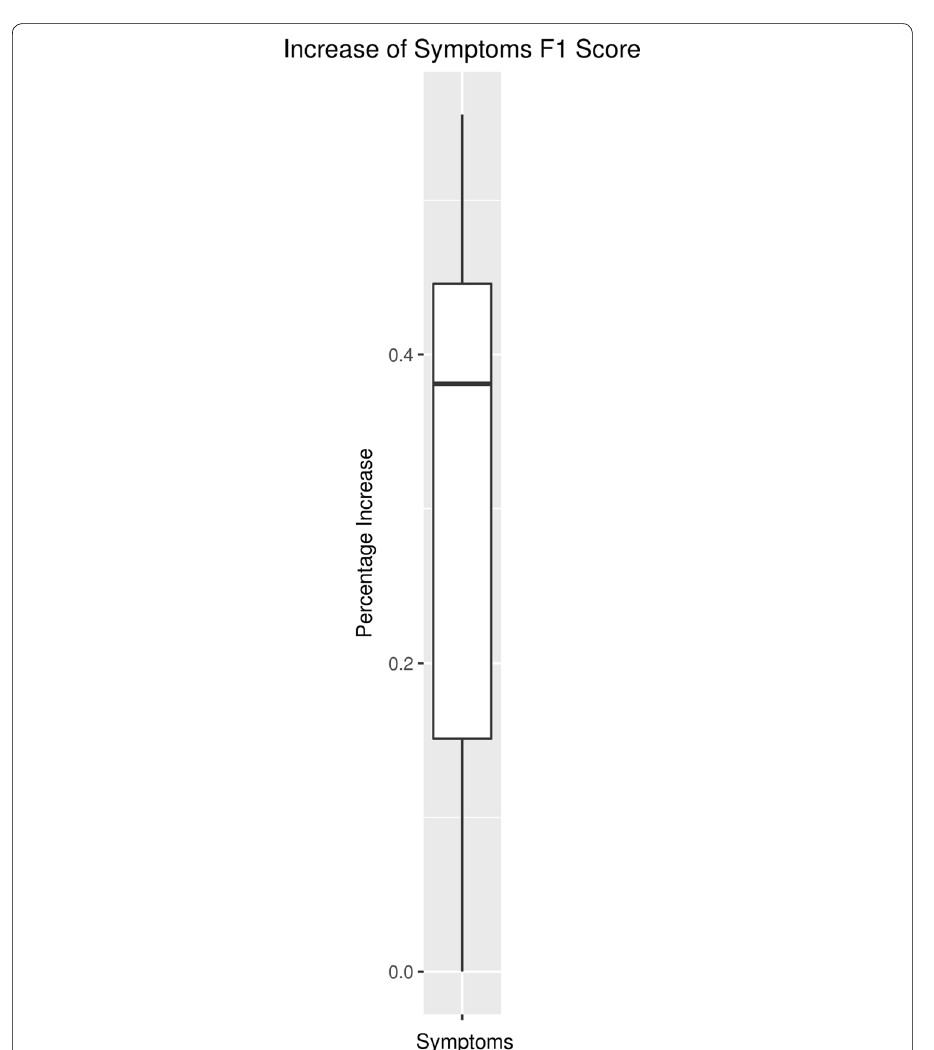
Fig. 12 Box and whisker plot of the percentage increase of F1 scores for baseline vs COED methodologies. Median percentage increase for symptoms F1 score is 38.1%